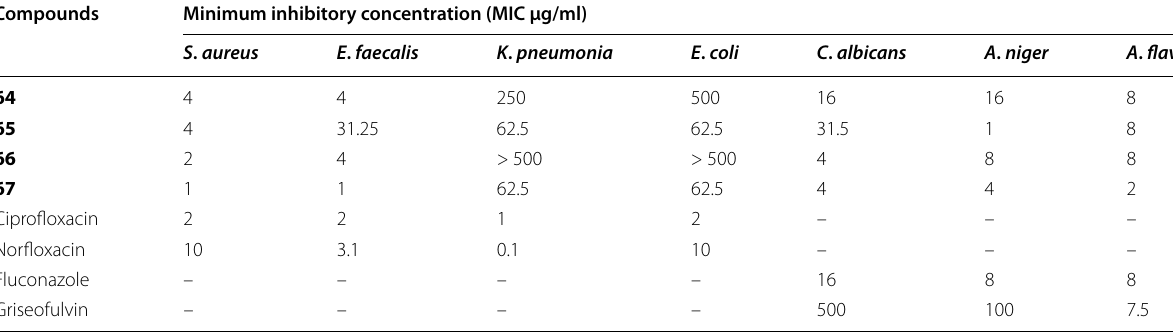
Table 19 Antimicrobial activities of synthesized compounds